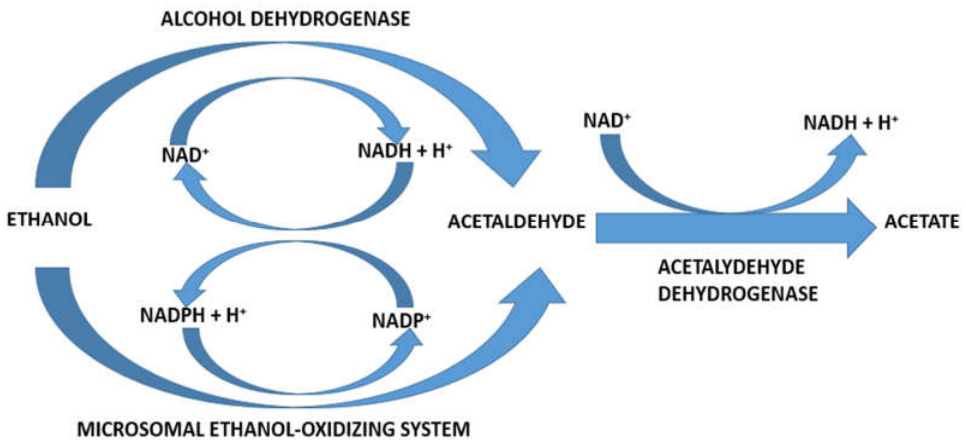
Figure 5. Interconnected action of hepatic alcohol dehydrogenase (ADH) and the microsomal ethanol-oxidizing system (MEOS). ADH produces reducing equivalents that are used by MEOS, showing that both enzymes depend on each other. The original figure was published in an earlier report [25], reproduced with permission of the Publisher Taylor & Francis (Didcot, UK).